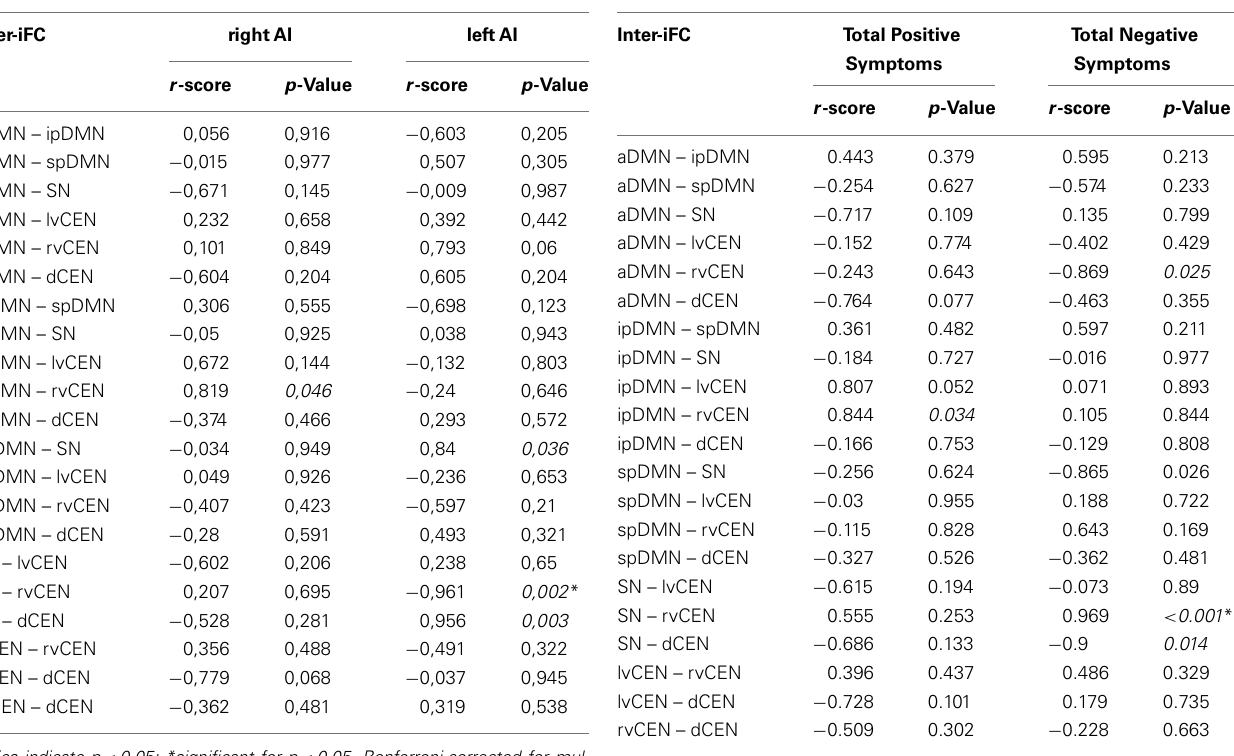
Table 8 | Partial correlations between inter-iFC and severity of positive and negative symptoms in patients with schizophrenia in state